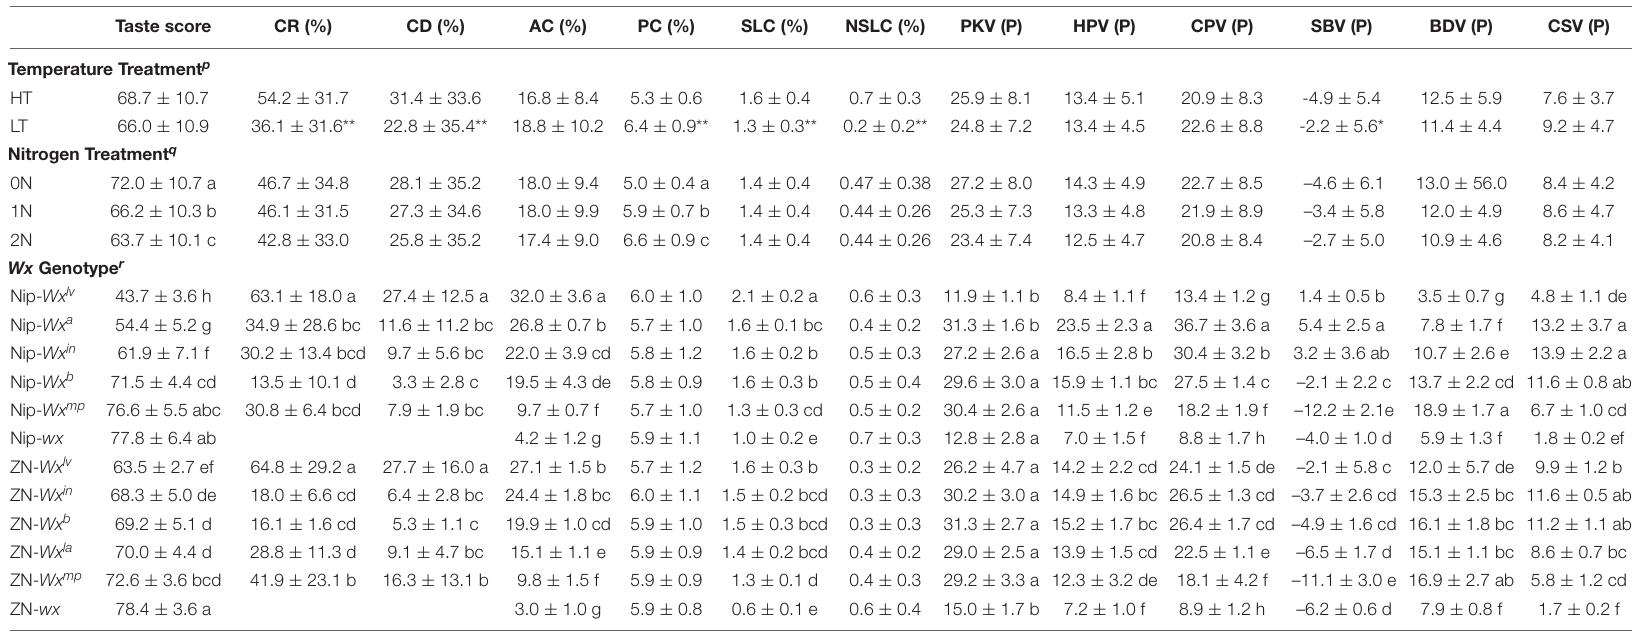
TABLE 1 | Phenotypic variation o of the tested materials at different temperatures and nitrogen